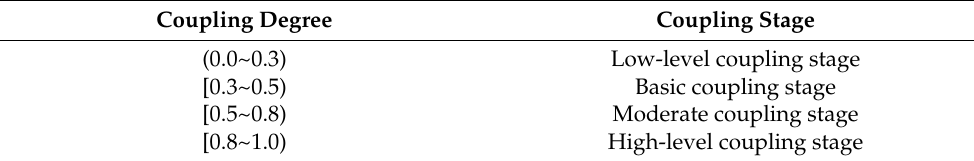
Table 2. Classification standard of coupling